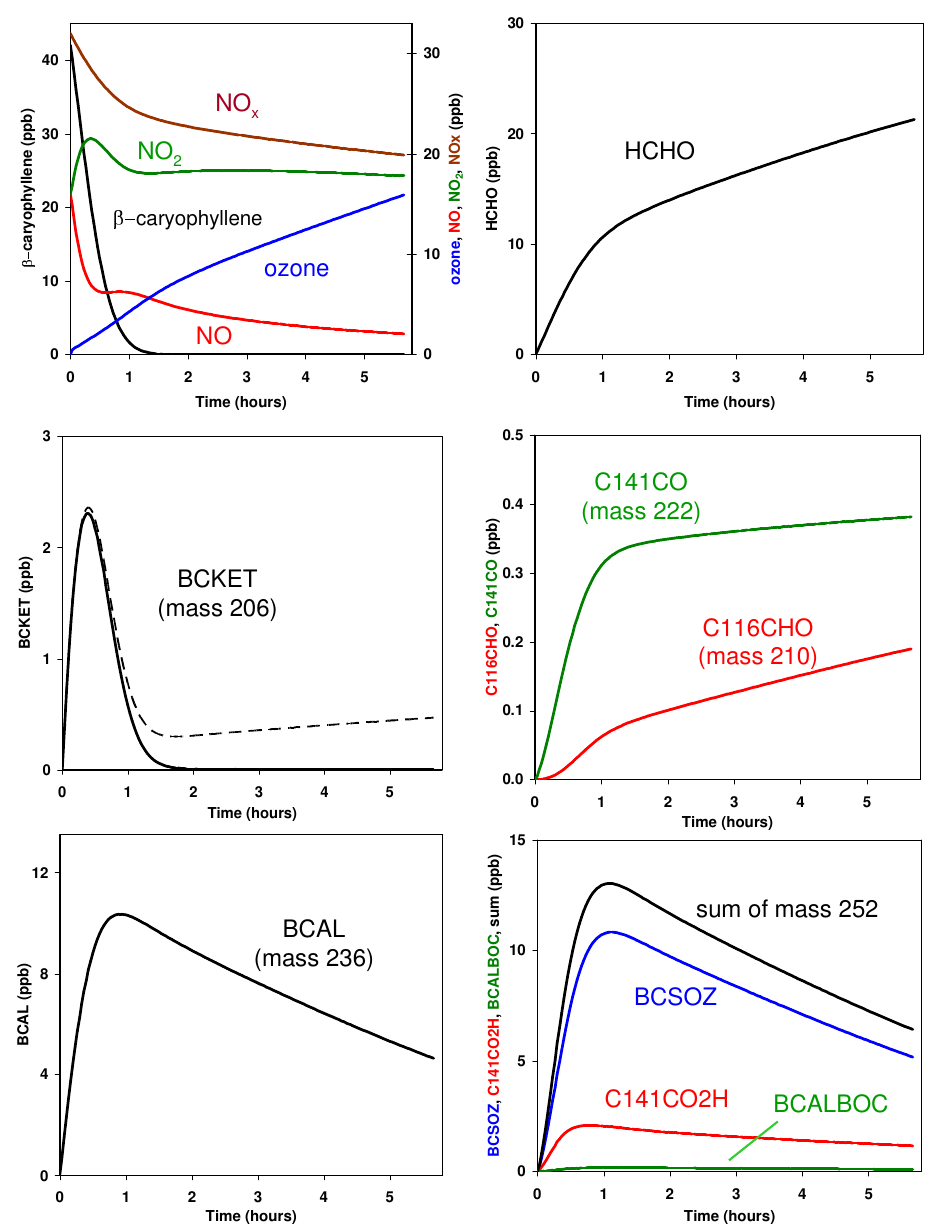
Fig. 20. Simulations designed to be indicative of the conditions of the photo-oxidation experiment reported in Figs. 1 and 3 of Lee et al. (2006b); with initial mixing ratios of 42ppb β -caryophyllene, 16ppb NO, 9.6ppb NO 2 and 6.4ppb HONO. Simulated profiles for NO 2 and NO x are assumed to include quantitative contributions from HONO and PANs (see Sect. 4.1). Product profiles can be compared with m / z data in Fig. 3 of Lee et al. (2006b), as follows: BCKET with m / z 207, 189; C116CHO with m / z 211; C141CO with m / z 223; BCAL with m / z 219; and sum of mass 252 with m / z 253, 235. Broken line in BCKET panel is the result of a senstivity test considering potential interfering signals (see